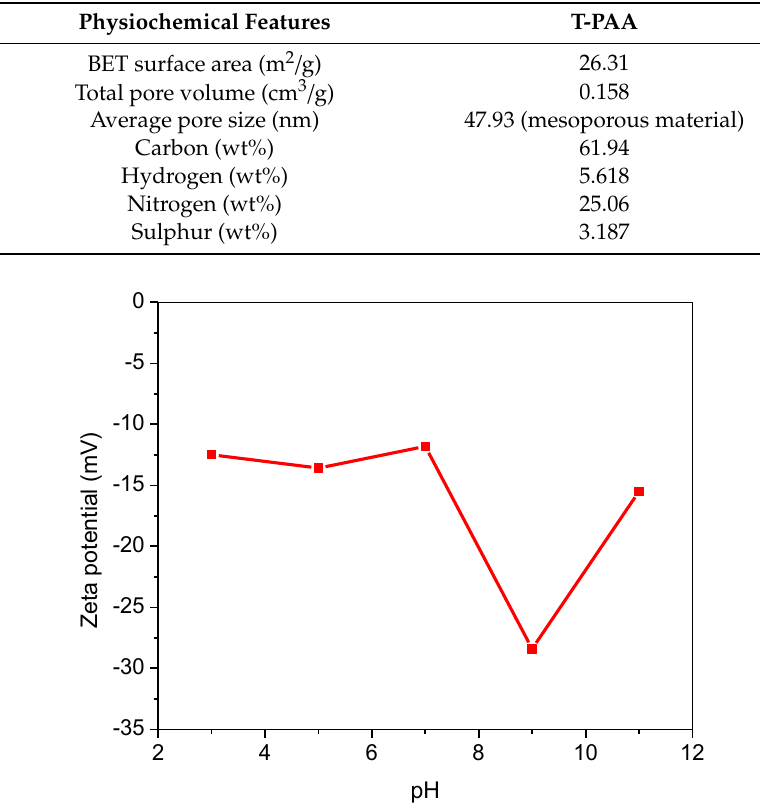
Figure 3. Zeta potential of thiourea-modified poly(acrylonitrile- co -acrylic acid) (T-PAA).